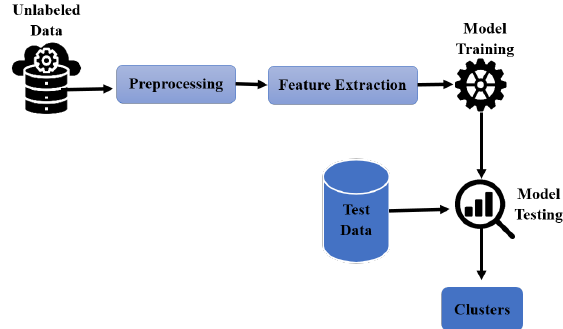
Figure 6. Structure of supervised Machine